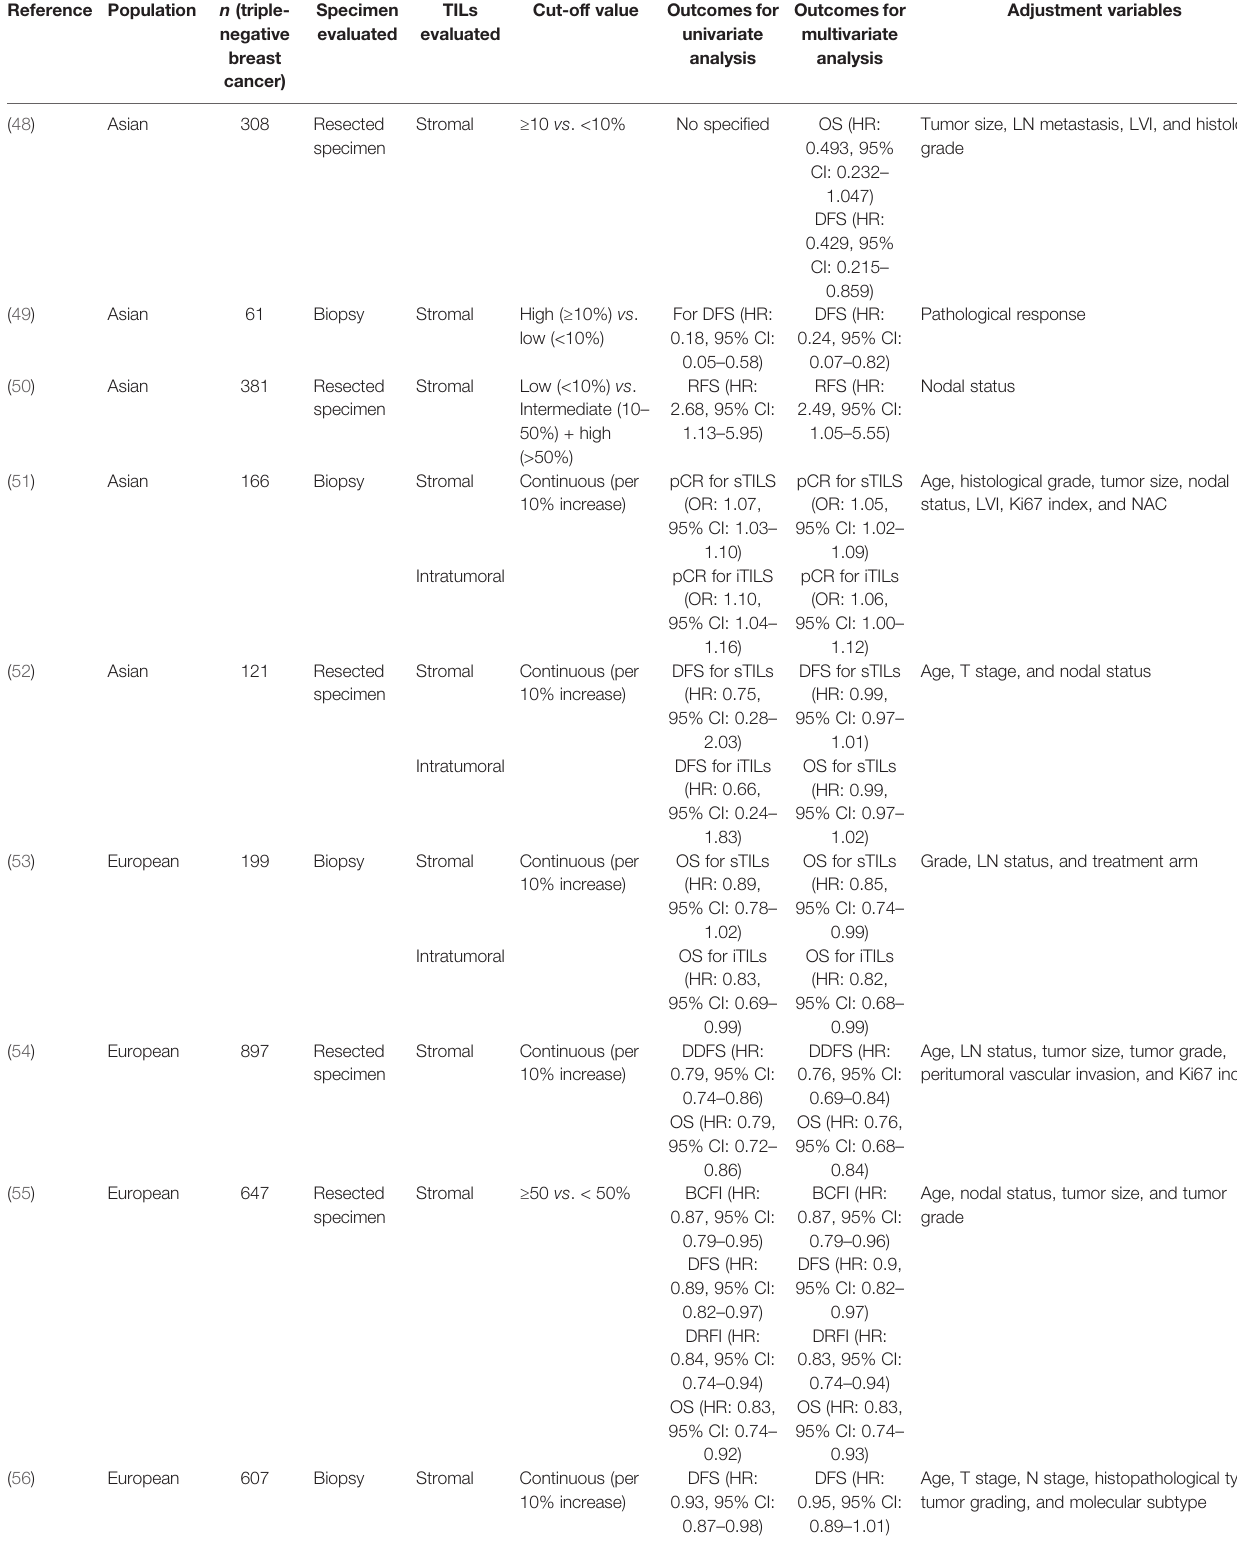
TABLE 1 | Outcomes from studies that analyzed tumor-in fi ltrating lymphocytes (TILs) according to the region of origin. Reference Population n (triple-